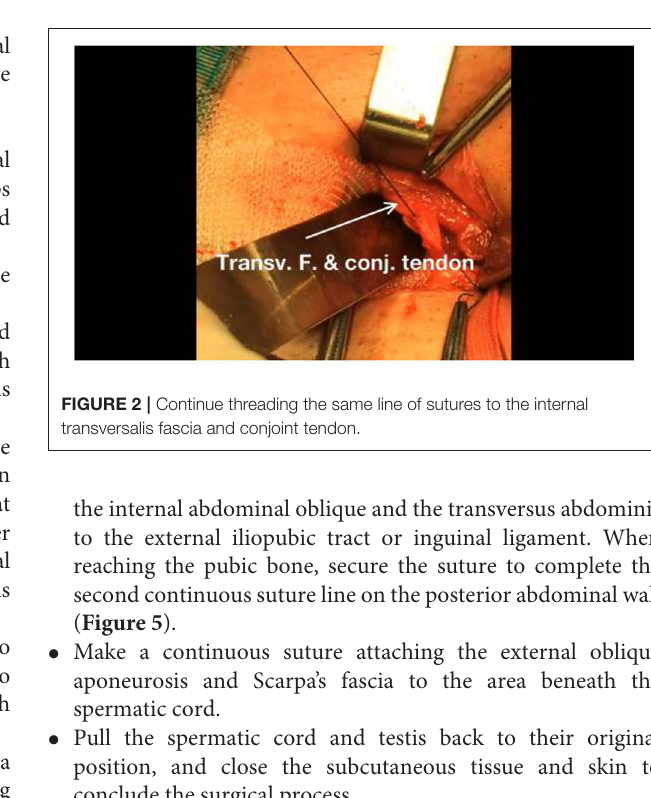
FIGURE 1 | The first thread of the needle should fixate the mesh to the area beneath the transversalis fascia in the external inguinal ring. The lower edge of the mesh should extend to at least 4cm below the superior of the pubic bone.